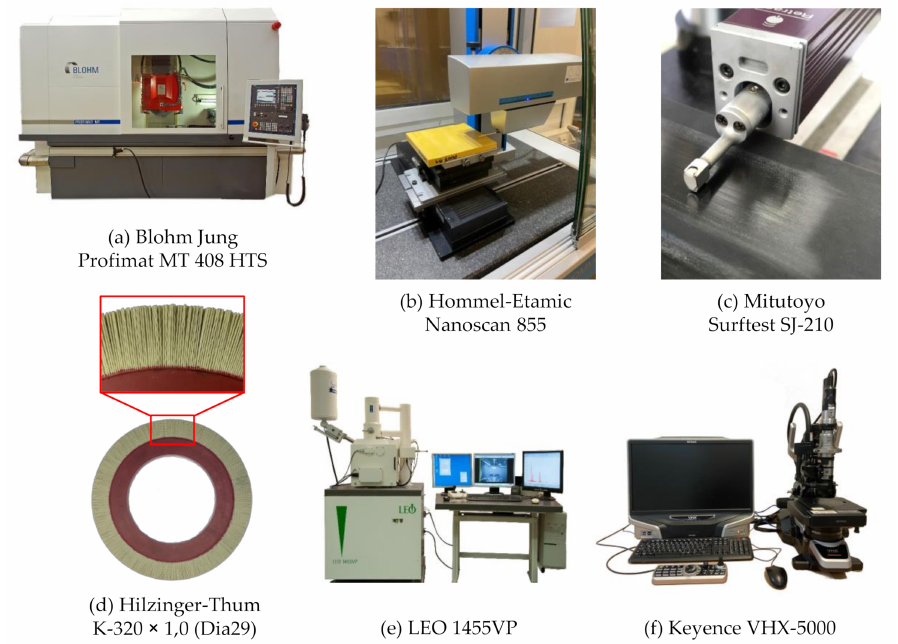
Figure 3. Experimental equipment: ( a ) profile grinding machine; ( b ) tactile surface measurement device; ( c ) tactile roughness measurement device; ( d ) exemplary circular brush used during technological investigations; ( e ) scanning electron microscope; ( f ) light microscope. Table 1. Variation of brushing tool specification and process parameters during the technological investigations. Grain Size s